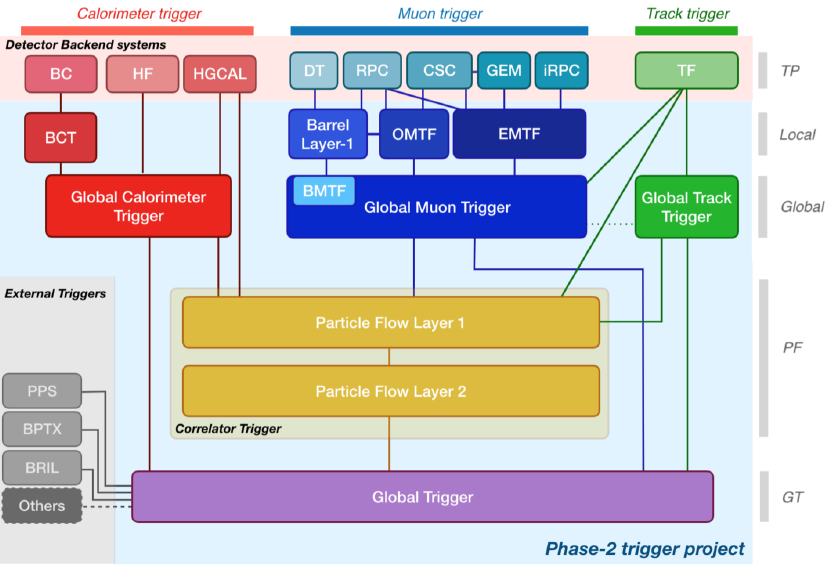
Figure 2. Block diagram of Phase-2 Level-1 trigger system [2]. It processes the information from sub-detectors, such as calorimeter, muon, and tracker. The trigger system is divided into five